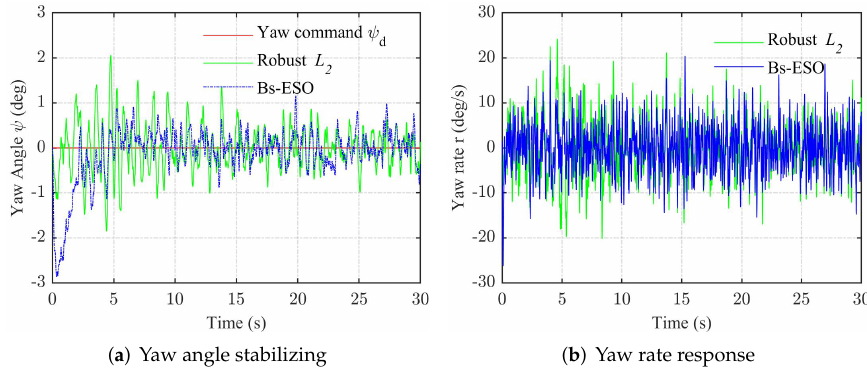
Figure 5. Yaw stabilizing performance under zero-mean noise disturbance.